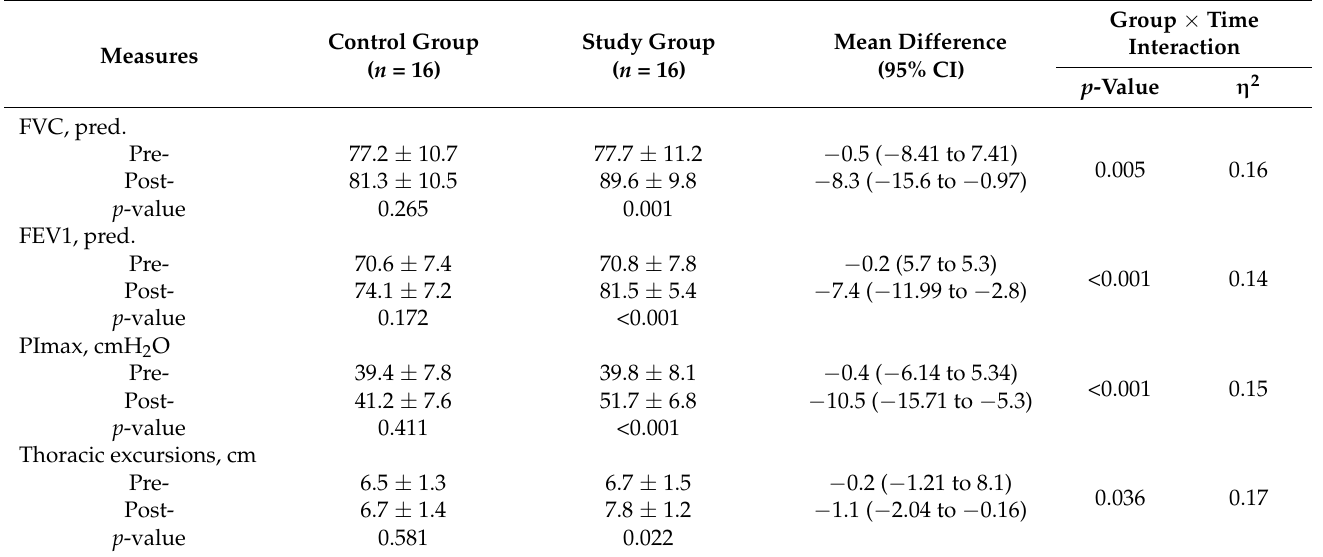
Table 2. Pre- and post-treatment differences intragroup and